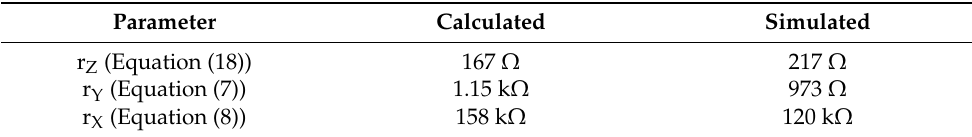
Table 3. The calculated simulated values of r Y , r X and r Z .